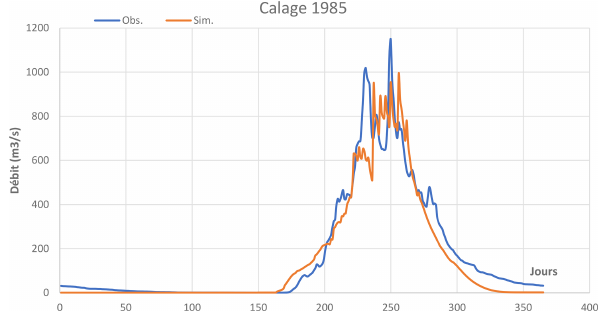
Figure 2. Hydrogrammes Bafing Makana : Calage année 1985.